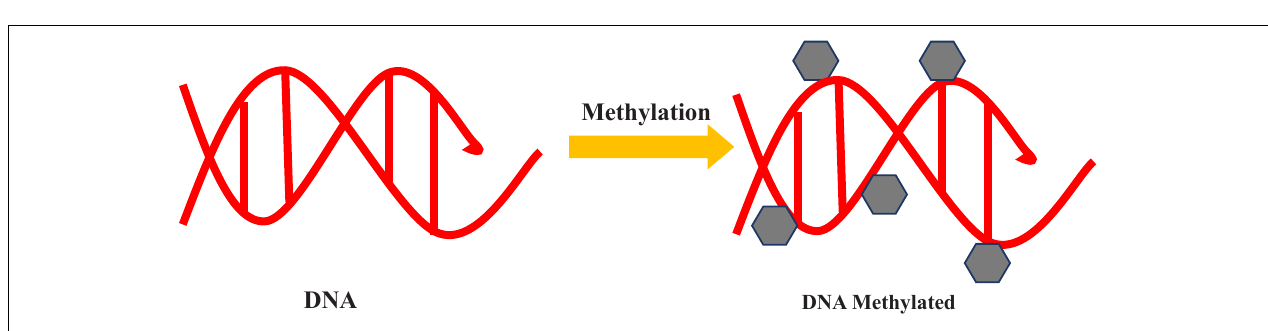
FIGURE 2 | Epigenetic modulation showing DNA methylation: attachment of methyl group at 5 (cid:48) -carbon atom of cytosine ring.